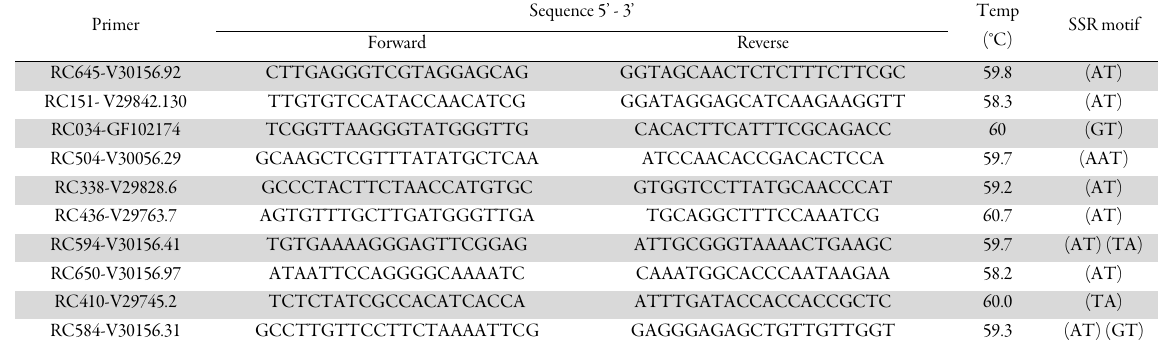
Table 1. List of simple sequence repeat (SSR) primers used for the genetic diversity study